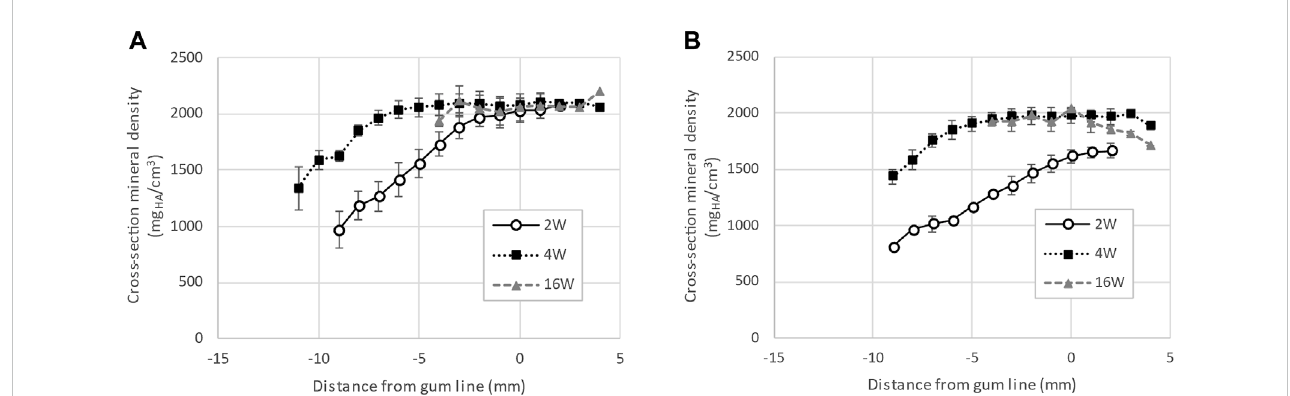
FIGURE 4 Progression of enamel mineral density for incisors, extracted from pigs aged 2, 4 and 16 weeks. Panel (A) shows the average density measured along the cross-section of the tooth while panel (B) shows the average density of the 30 µm near the surface of the tooth. The data indicates that enamel near the surface of fi rst incisors is not fully mineralized at eruption in 2-week-old